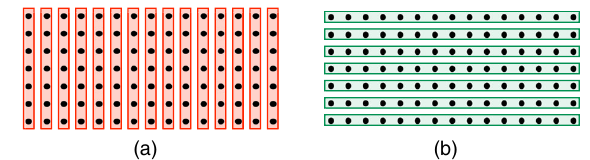
FIG. 2. Two different partitions of the [[105,1]] qubit stabilizer code, which is a concatenation of the 7-qubit and 15-qubit codes. Each row of the 7 × 15 array is an instance of the 15-qubit code that encodes one of the qubits of the 7-qubit code. Depending on the partition of the qubits, the code can have either a transversal logical (a) T ¼ diag ð 1 ; exp 2 π i= 8 Þ or (b) Hadamard gate. Here, a transversal unitary with respect to a given partition is a tensor product of unitaries, each of which is supported only on qubits within one subset of the partition (red or green